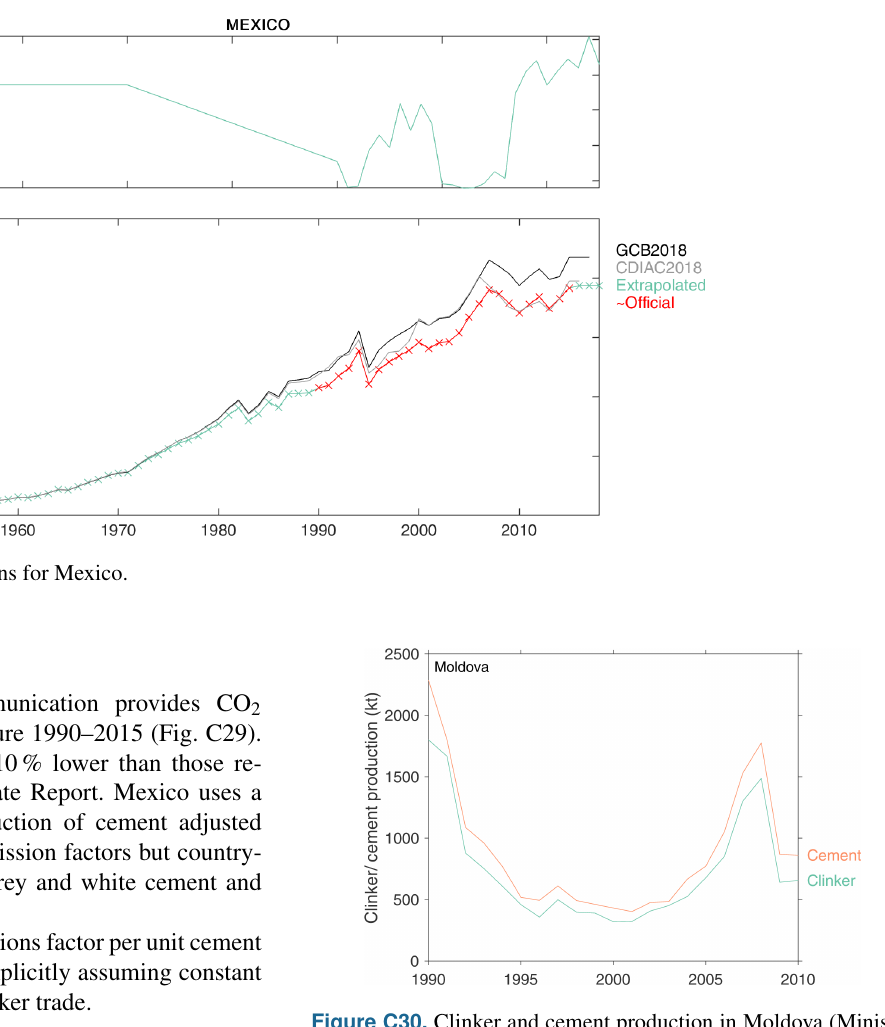
Figure C30. Clinker and cement production in Moldova (Ministry of Environment,